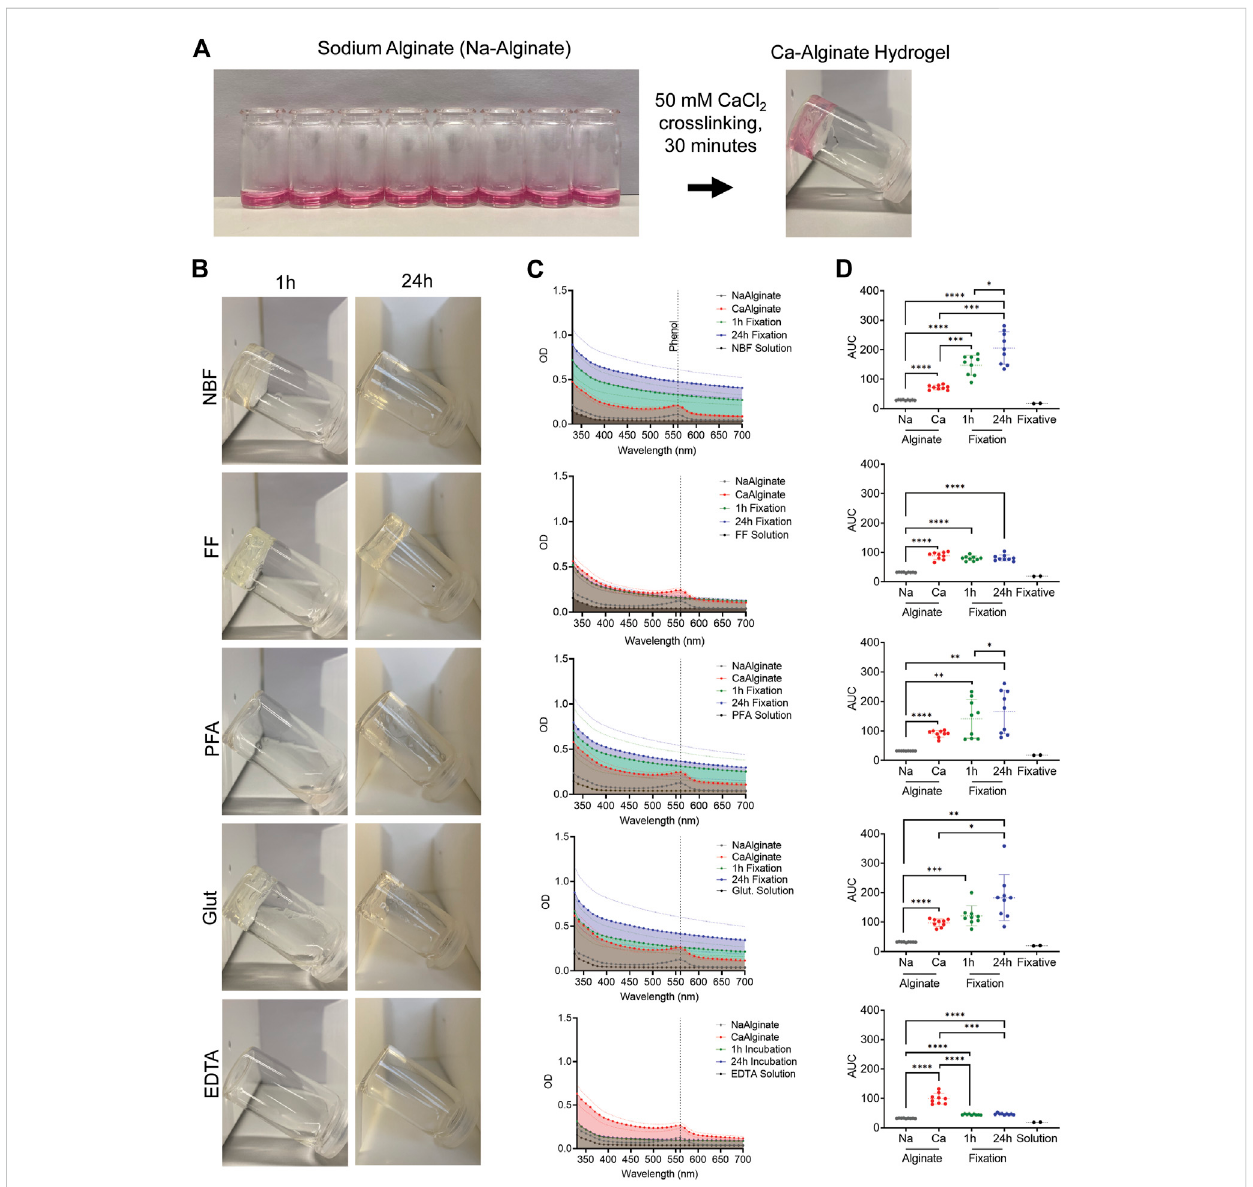
FIGURE 2 Fixation of calcium alginate hydrogels with different commercial fi xatives for inverted vial test and UV-Vis Spectroscopy. (A) Crosslinking of sodium alginate in DMEM/F12 media to calcium alginate was performed in 5 mL glass vials using CaCl 2 to form hydrogels. (B) Representative photomicrographs of hydrogels, with liquid removed, at an inclination of 45 ° after 1 and 24 h fi xation in commercially available fi xatives: neutral-buffered formalin (NBF), formalin free fi xative (FF), paraformaldehyde in 0.1M phosphate buffer (PFA), glutaraldehyde (Glut) and 25 mM EDTA as dissolution control. (C) UV- Vis absorption spectra across all experimental time points: sodium alginate (gray), calcium alginate (red), 1 h fi xation (green), 24 h fi xation (blue) and pure fi xative solution (black). (D) Area under the curve (AUC) calculated per condition, the same color code is used as for UV-Vis absorption spectra. Statistical analysis for all fi xatives was evaluated using a repeated measure two-way ANOVA comparing changes in AUC across all experimental conditions and fi xatives. Repeated measures with Geisser-Greenhouse correction and Tukey ’ s multiple comparisons test with individual variances computed for